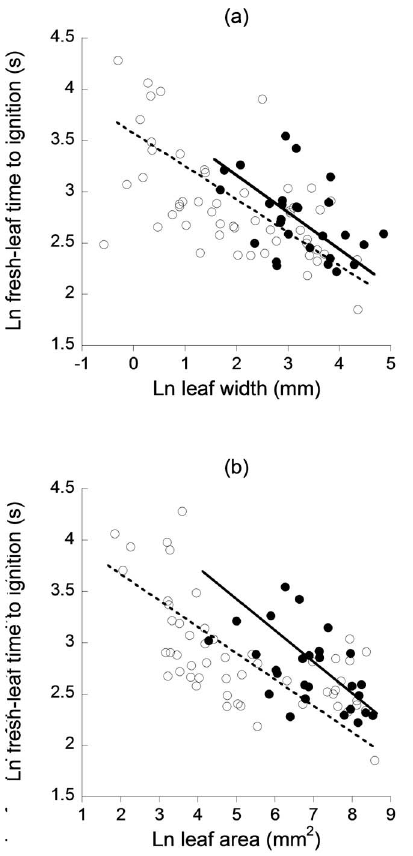
Figure 2. Scaling relationships between fresh-leaf flammability and (a) leaf width and (b) leaf area. Native species are represented by open circles and dashed lines and exotic species by closed circles and solid